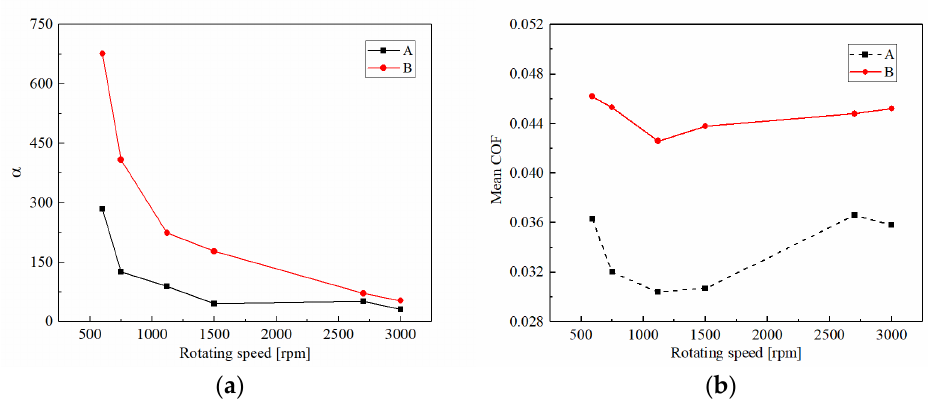
Figure 9. The variable coefficients of friction torque in stable working stage ( a ) and the mean COF of CBFM-A and CBFM-B ( b ) at different rotating speeds.